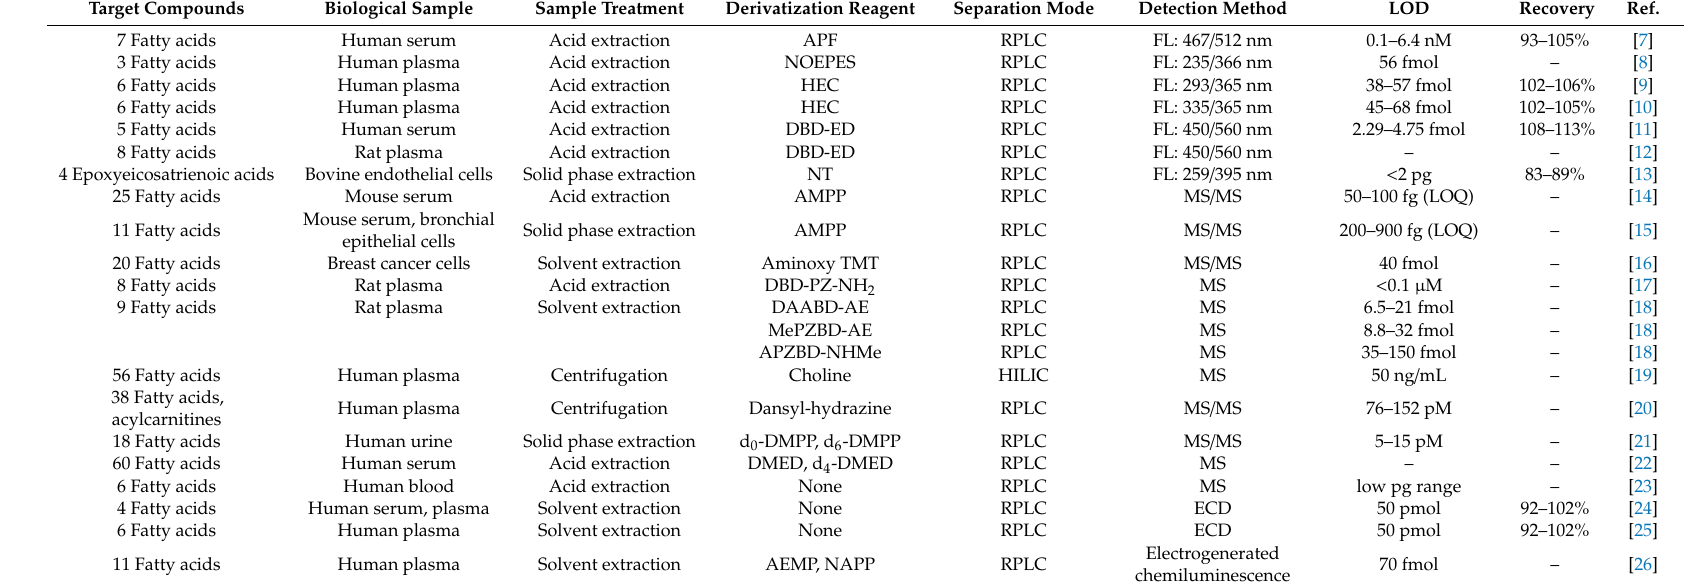
Table 1. Analytical methods for fatty acids in biological